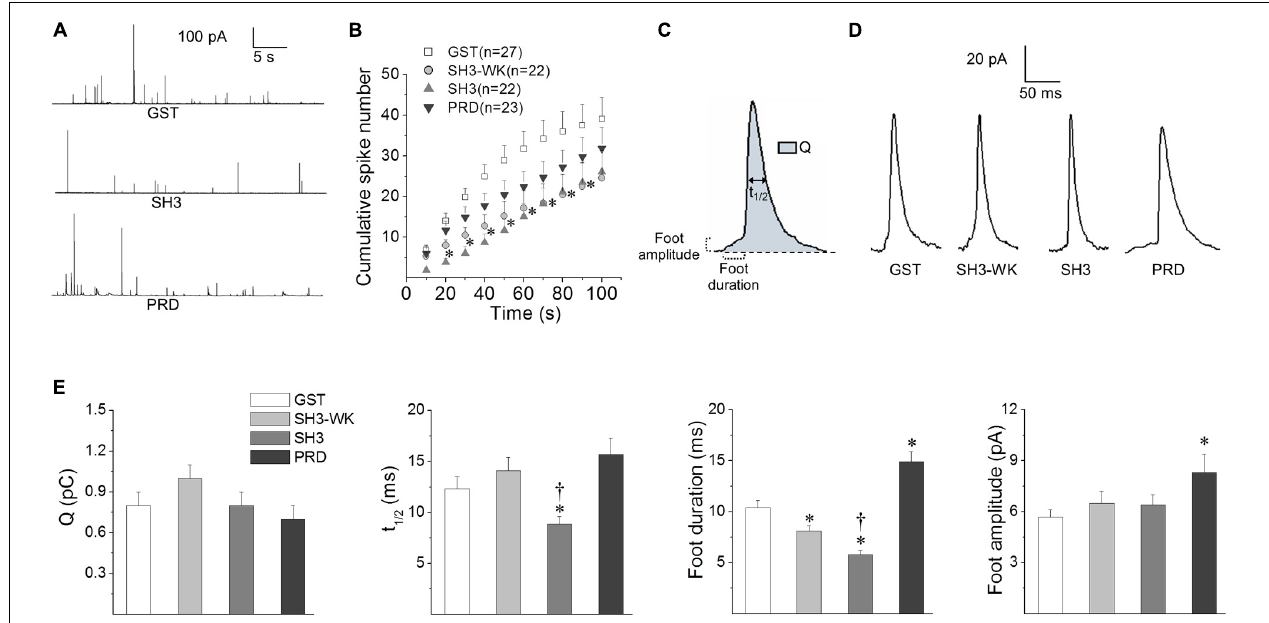
FIGURE 3 | Effects of the cortactin SH3 domain and the N-WASP PRD on exocytosis. Chromaffin cells were injected with 5 µ M of GST alone, GST-cortactin SH3 (SH3), a mutated version of GST-cortactin SH3 defective in binding PRD (SH3-WK) or GST-N-WASP PRD (PRD). The exocytosis response evoked by a 10 s pulse of 50 µ M DMPP was monitored by amperometry 30–45 min after injections. The amperometric recordings lasted 100 s. (A) Examples of 40 s amperometric traces from cells injected with GST, SH3 or PRD peptides. (B) Cumulative histograms of the number of amperometric spikes from cells injected with GST (white squares), SH3-WK (light-gray circles), SH3 (light-gray triangles) or PRD (dark-gray inverted triangles). Numbers between parentheses indicate the number of cells obtained from at least three different cultures. Notice that both SH3-WK and SH3 significantly reduced the number of spikes between 20 and 80 s. ∗ p < 0.05 compared to GST (one-way ANOVA followed by unpaired t -test). (C) Scheme of an amperometric spike with the analyzed parameters: quantal size (Q), half width (t 1 / 2 ), foot duration and foot amplitude. (D) Examples of amperometric spikes from cells injected with GST, SH3-WK, SH3 or PRD. (E) The graphs show mean values of medians determined for single cells of Q, t 1 / 2 , foot duration and foot amplitude of amperometric spikes from cells injected with GST (white bars), SH3-WK (light-gray bars), SH3 (gray bars) or PRD (dark-gray bars). Data are represented as means ± SEM. Numbers of cells for each condition are the same as indicated in (B) . ∗ p < 0.05 compared with GST; † p < 0.05 compared with SH3-WK (one-way ANOVA followed by unpaired t